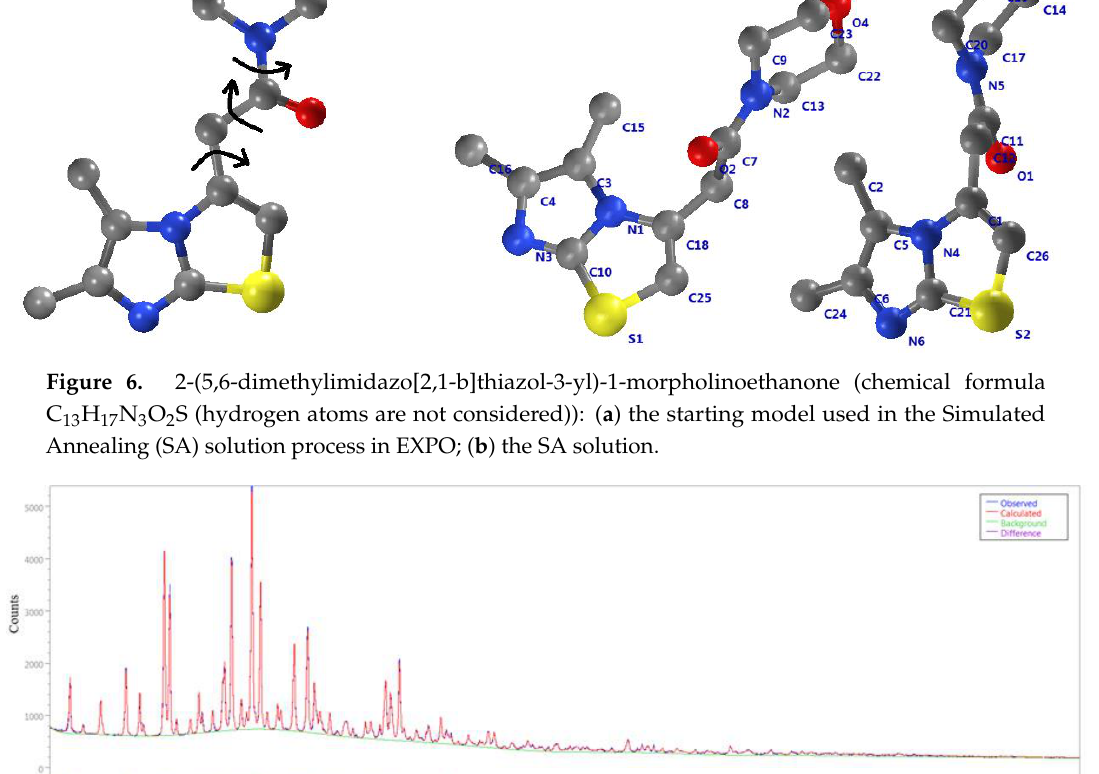
Figure 6. 2-(5,6-dimethylimidazo[2 ,1-b]thiazol-3-yl)-1-morpholinoethanone (chemical formula C 13 H 17 N 3 O 2 S (hydrogen atoms are not considered)): ( a ) the starting model used in the Simulated Annealing (SA) solution process in EXPO; ( b ) the SA solution.